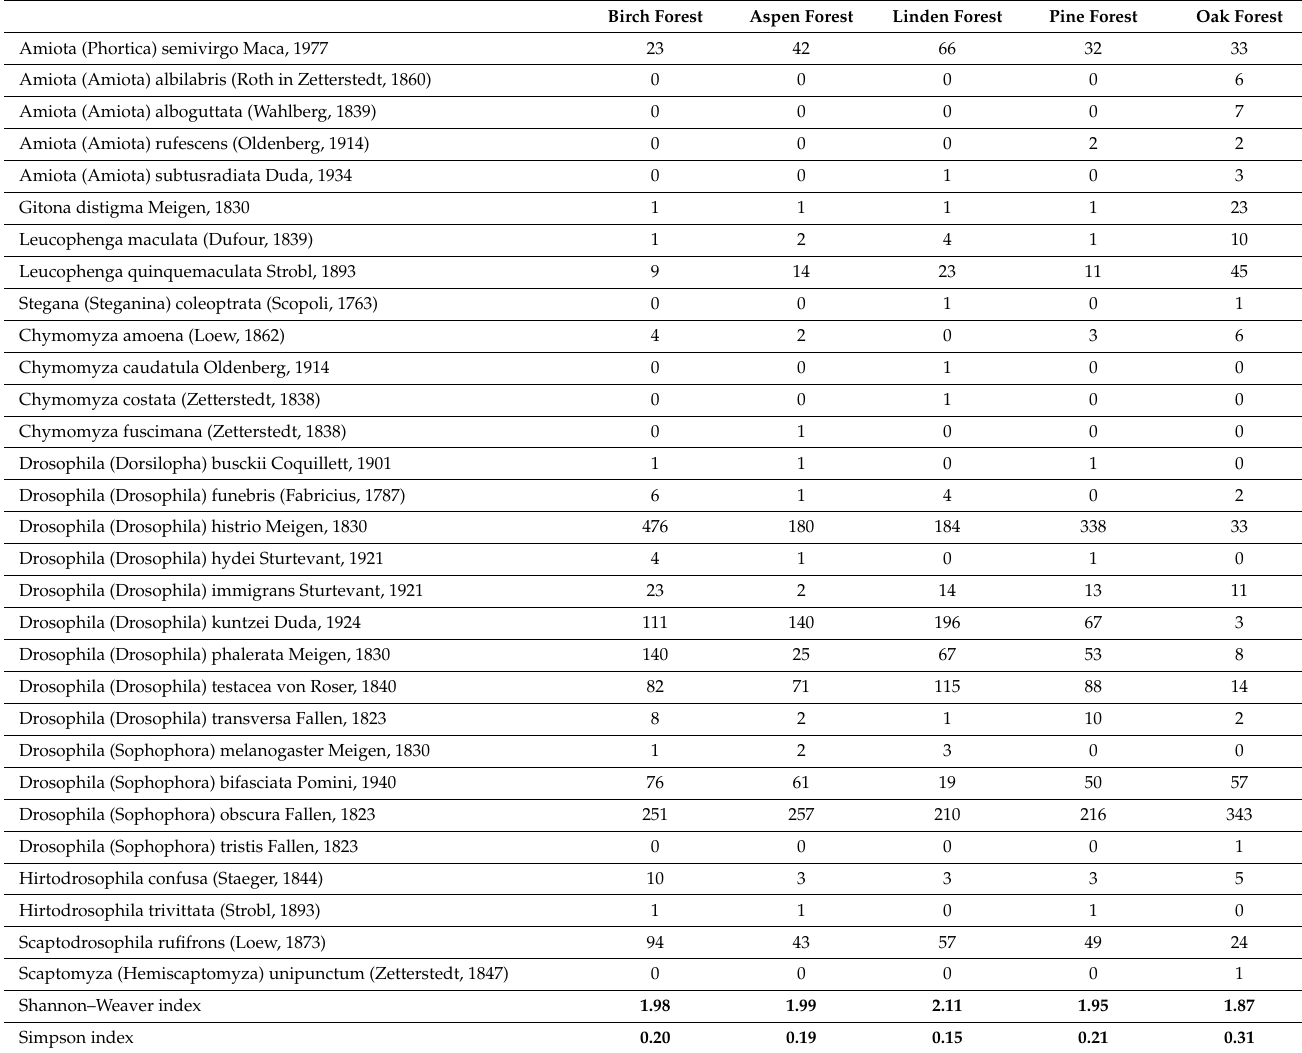
Table A10. Drosophilid specimens collected in five biotopes with calculated Shannon–Weaver and Simpson indexes. Birch Forest Aspen Forest Linden Forest Pine